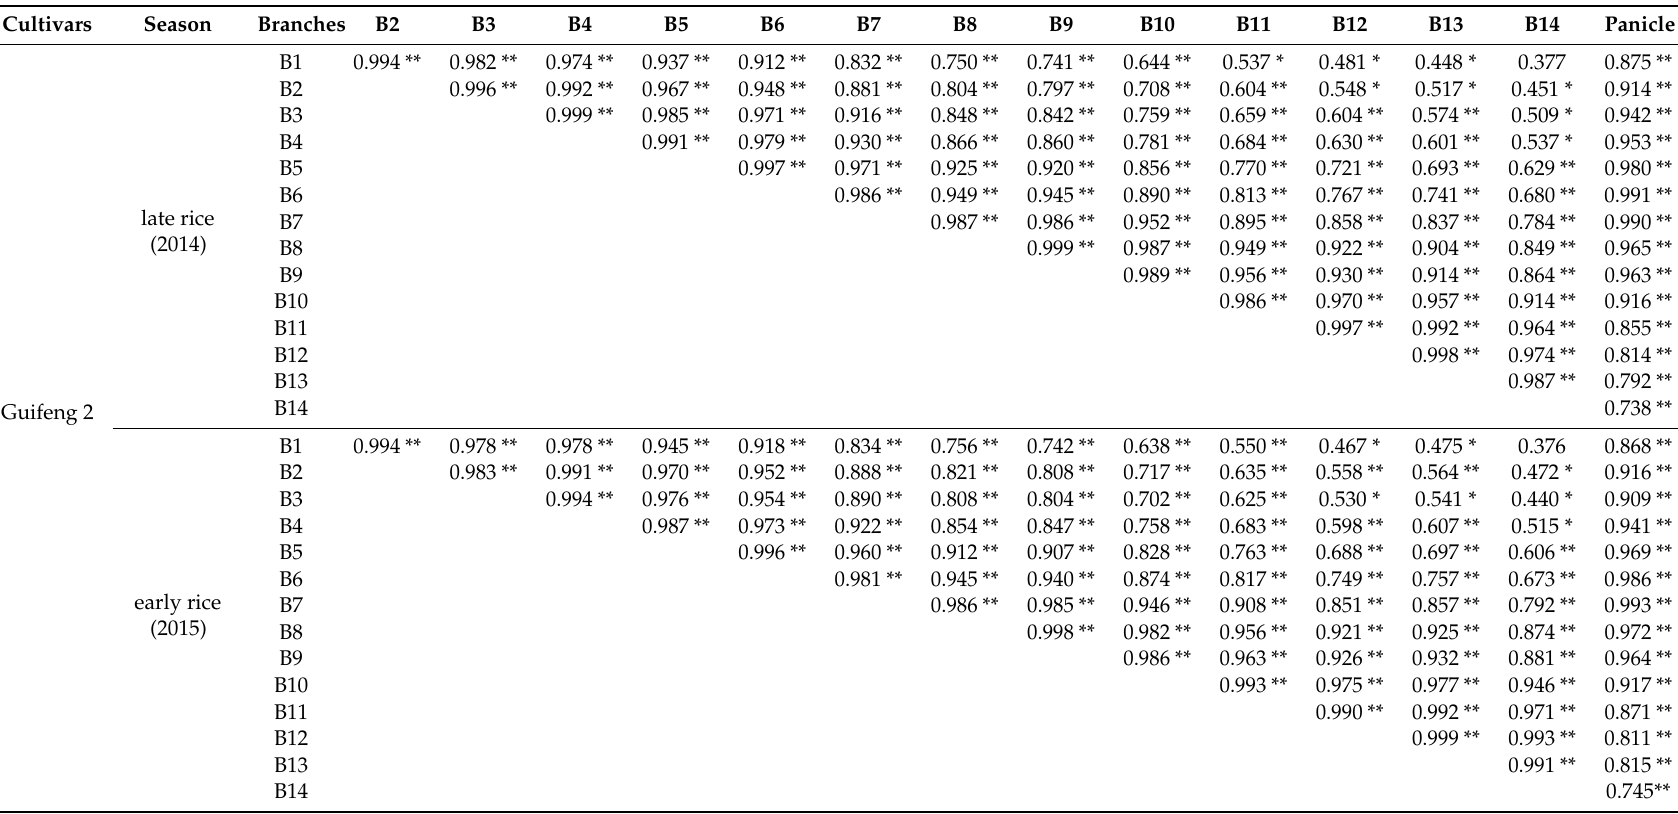
Table 3. The correlation coe ffi cients of dry-matter accumulation between primary-branch grains and the whole panicle of Guifeng 2 in 2014 and 2015. B1 to B14 represent the 1st primary-branch grains to the 14th primary-branch grains from the top to the base of the panicle for Nongle 1 and Guifeng 2. Panicle indicates the whole panicle of Guifeng 2. *, significance at the 0.05 probability level; **, significance at the 0.01 probability